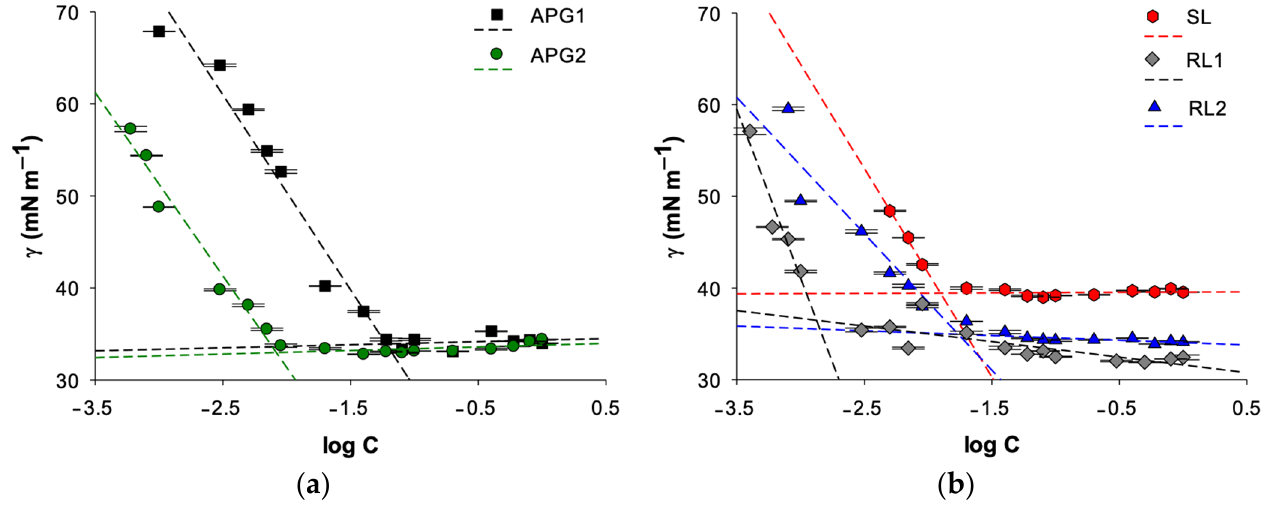
Figure 2. Surface tension vs. log of surfactant concentration for ( a ) synthetic surfactants (APG1 and APG2: alkyl polyglycosides); ( b ) biosurfactants (SL: sophorolipid, RL1 and RL2: rhamnolipids). Table 2. Micellar and surface properties of surfactants aqueous solutions at 298.15 K and atmos- pheric pressure.